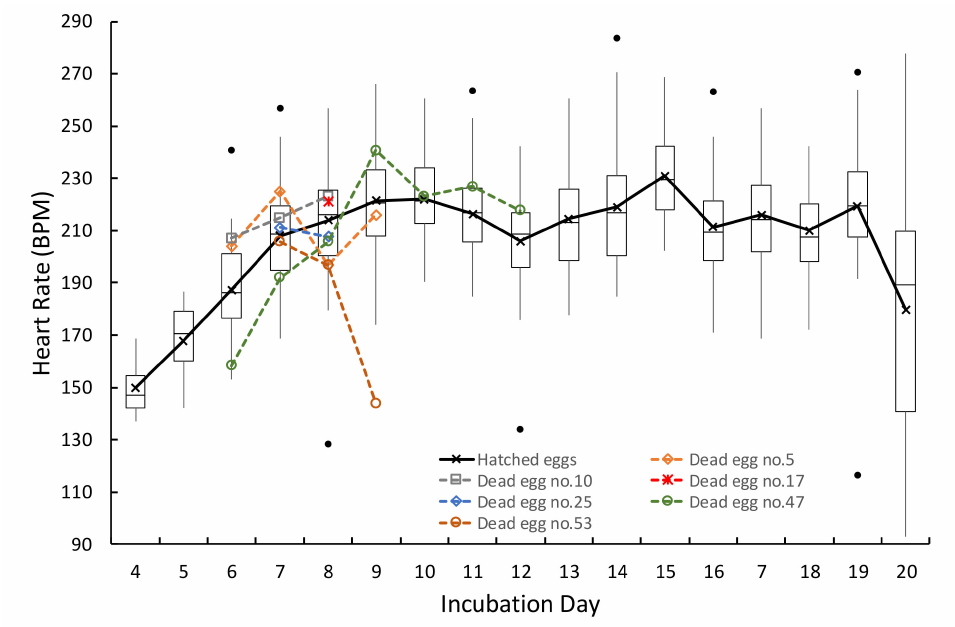
Figure 5. Mean embryonic HR obtained during incubation, from fertile and live eggs using the proposed smartphone device setup and the custom Android application. The daily HRs obtained from 6 dead embryos are given for